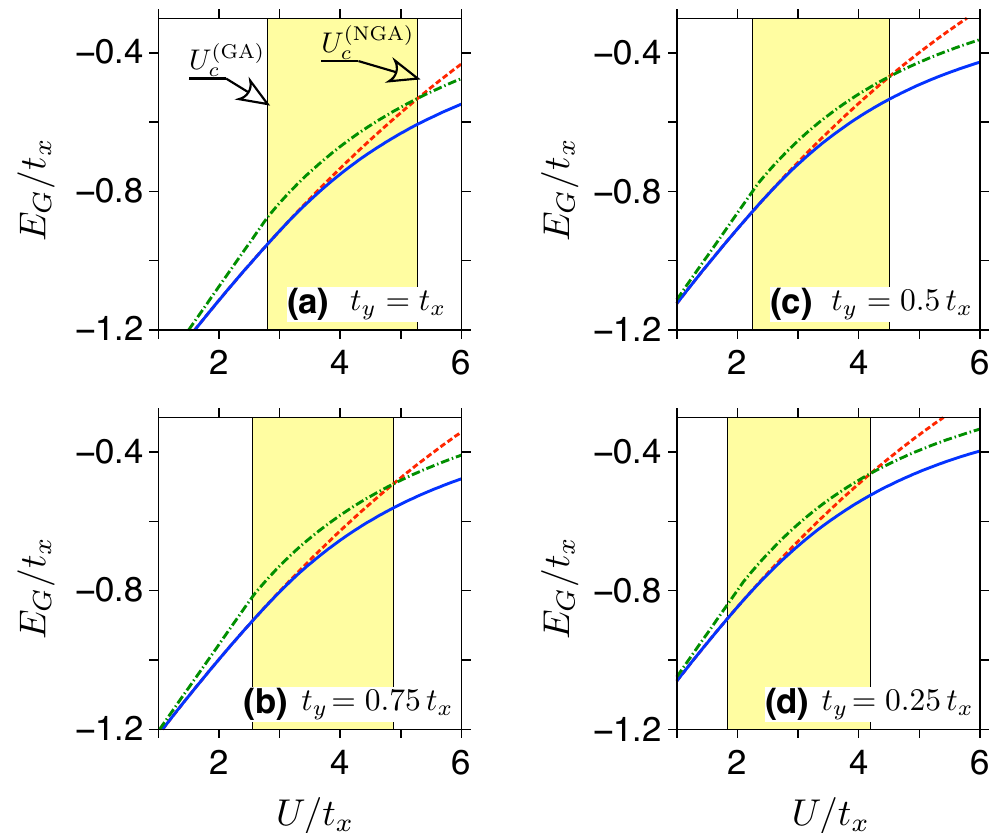
Figure 4. ( a – d ) The lower and the upper bounds to the critical Hubbard repulsion U c for anisotropic honeycomb lattice estimated by comparing different versions of the Gutzwiller Approximation described in the text. The lower bound ( U ( GA ) c ) coincides with the splitting of the Gutzwiller energy ( m = 0 ) , given by Equation (19) [red dashed line] and the variational for paramagnetic state, E ( GA ) G energy E ( GA ) , see Equation (17), with the parameters ( m , d ) optimized numerically [blue solid line], G both displayed as functions of U . The value of U ( GA ) c is obtained via the extrapolation with m 0, → ( m = 0 ) with E NGA similarly as for the VMC results in Figure 3. The intersection of E ( GA ) , see G G Equation (20) [green dashed-dotted line] yields the upper bound ( U ( NGA ) c ). The value of the t y / t x ratio is varied between the panels. [For the numerical values of U ( GA ) c and U ( NGA ) c , see Table